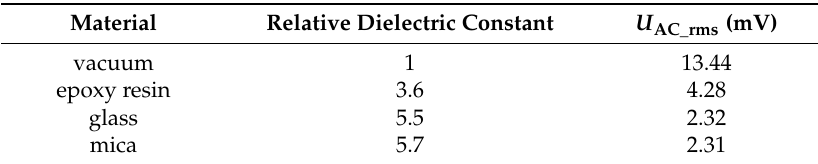
Table 4. U AC_rms obtained by setting different filling